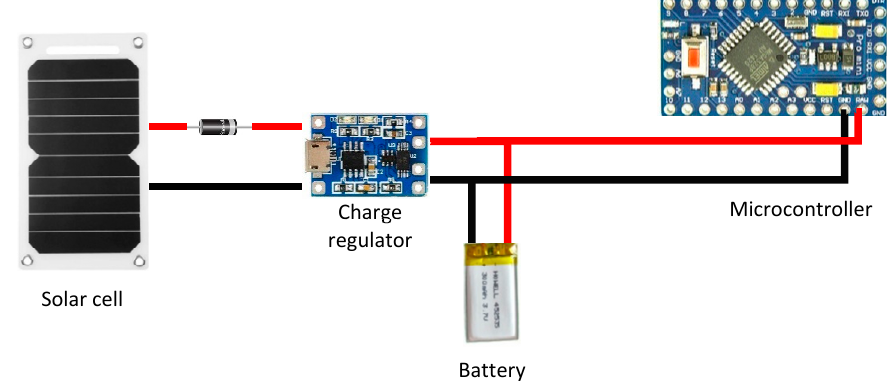
Figure 18. Example of a solar-powered system composed of a solar module, a charge regulator and a microcontroller. The voltage regulator receives an input voltage from the solar cell in the range of 0.3 V to 6 V. The charge regulator manages the charge of the battery (at constant voltage and current). The battery is connected in parallel to the internal voltage regulator of the microcontroller of the system.